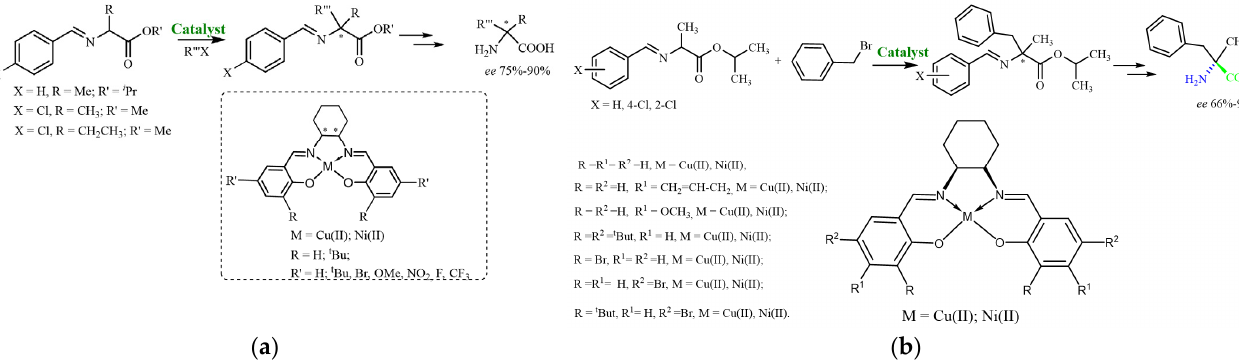
Figure 1. Asymmetric alkylation of amino acid enolates under PTC according to the previous scientific literature ( a ) and the current work ( b ).